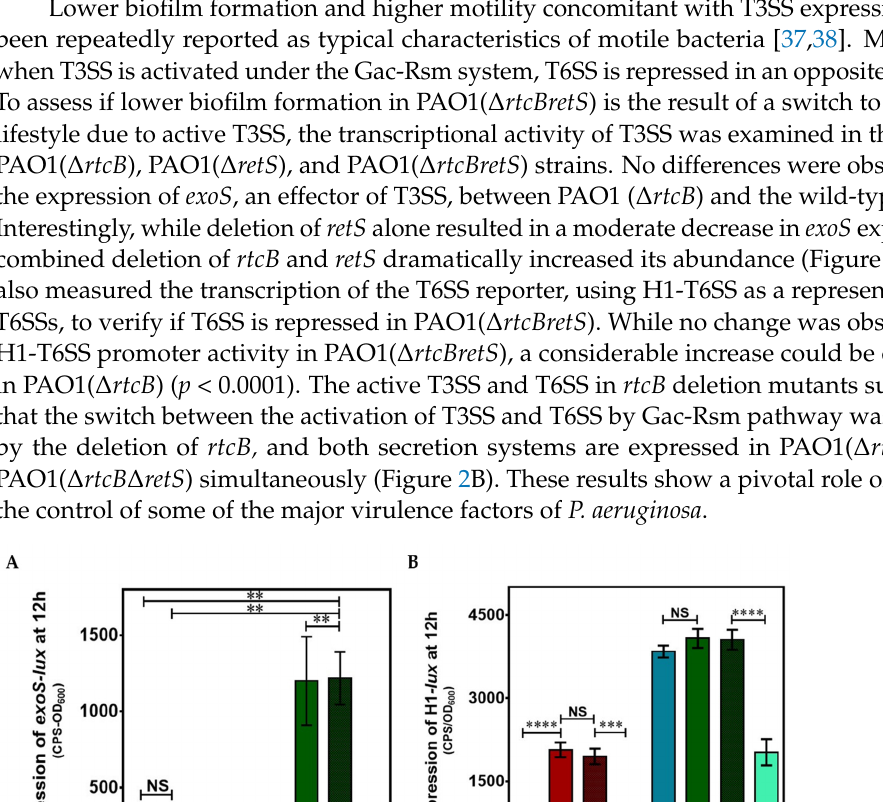
Figure 1. Deletion of rtcB influenced multiple virulence factors of P. aeruginosa . ( A ) Measurement of pyocyanin production in PAO1, PAO1( ∆ rtcB ), PAO1( ∆ retS ), and PAO1( ∆ rtcB ∆ retS ), and the complemented deletion strains with rtcB expression vector. Pyocyanin was produced in significantly higher amounts in PAO1( ∆ rtc B) and PAO1 ( ∆ retS ) compared to PAO1. The complementation of rtcB deletion mutants restored the pyocyanin production. ( B ) Biofilm formation was assayed in a 96-multi-well plate under static conditions. Biofilm formation was significantly higher in PAO1( ∆ retS ) than in PAO1. The PAO1( ∆ rtcB ∆ retS ) strain formed significantly less biofilms compared to PAO1( ∆ retS ). Biofilm formation in the com- plemented strains returned to the levels of PAO1 and PAO1( ∆ retS ), respectively. ( C ) Motility assays revealed that swarm- ing and swimming motilities of PAO1( ∆ rtcB ) were decreased compared to the wild-type PAO1. Swarming, swimming, and twitching were increased in PAO1( ∆ rtcB ∆ retS ) compared with PAO1( ∆ retS ). Overexpression of rtcB in the rtcB dele- tion strains reduced the motilities to levels similar to the background. ( A,B ): Data from three independent experiments were analyzed using one-way ANOVA with Dunnette post-hoc test. ( C ): images are representative of three independent experiments. ns, p > 0.05, * p < 0.05, *** p < 0.001, and **** p < 0.0001.